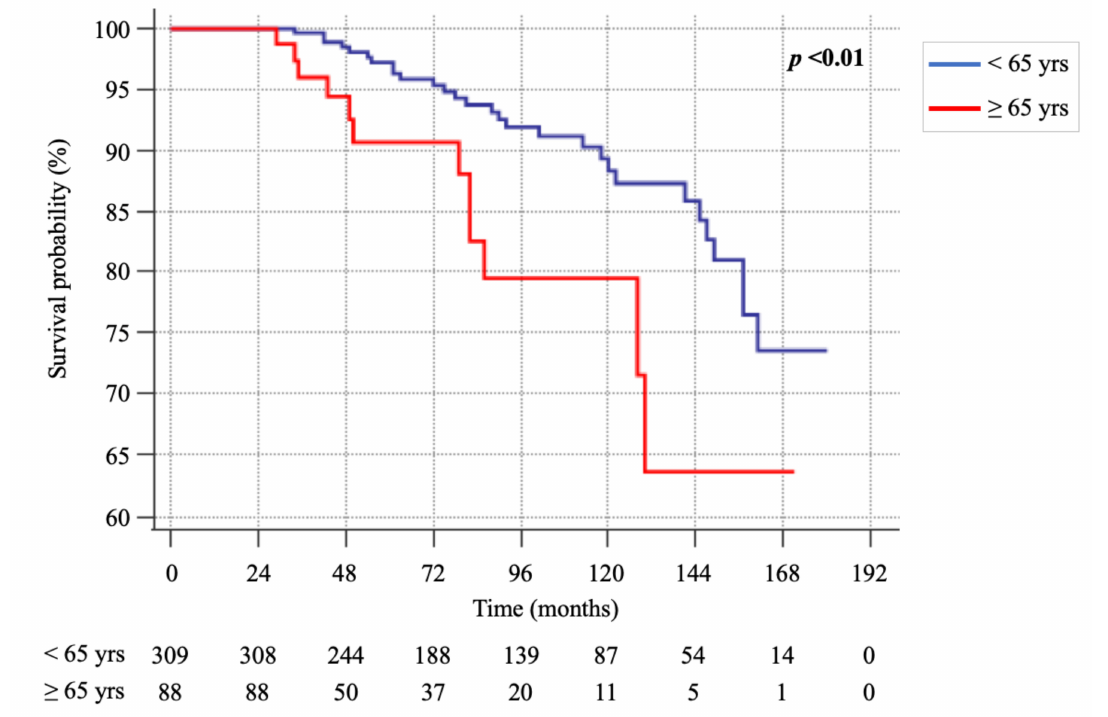
Figure 1. Kaplan-Meier survival curves of group A (<65 yrs) and B ( ≥ 65 yrs).